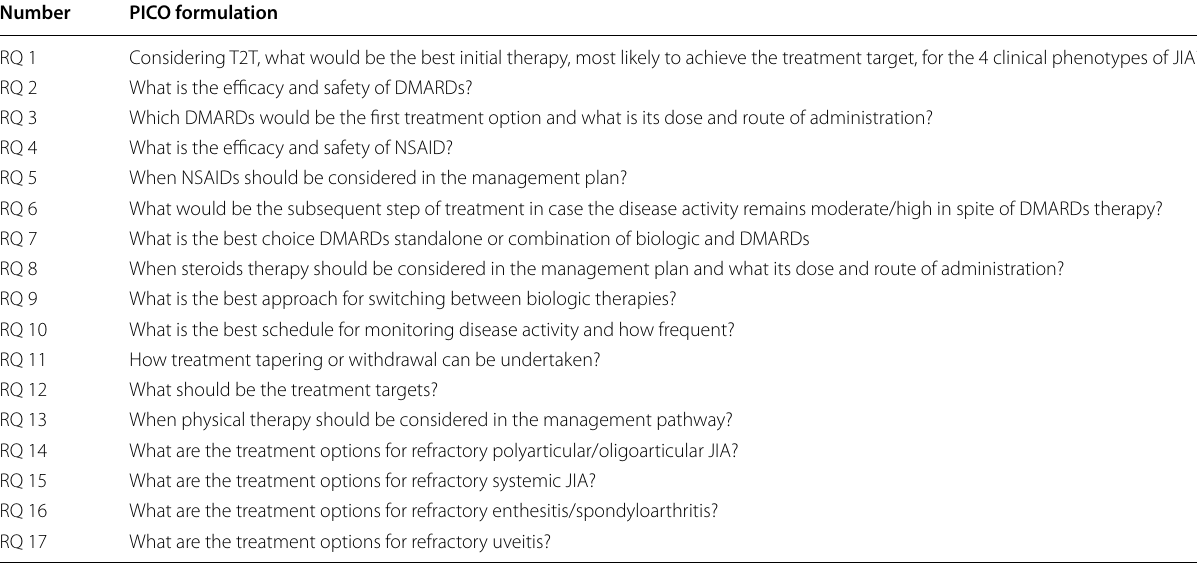
Table 1 PICO research questions declared by the core team for development of the